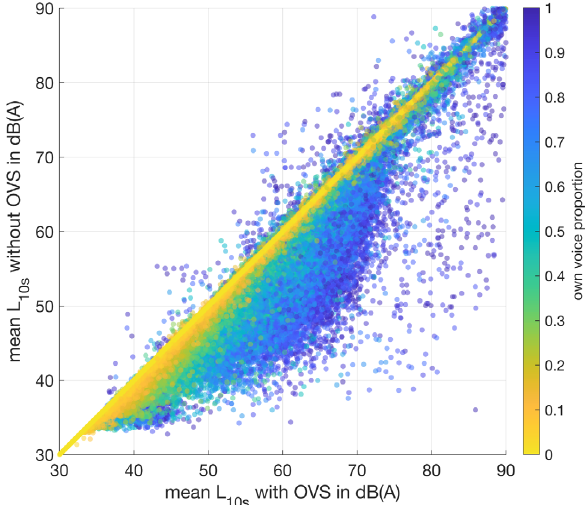
Figure 8. Distribution of the mean A-weighted SPL calculated for 10 s-intervals with 50% overlap for all recording days of one participant, on the horizontal axis including OVS and on the vertical axis excluding OVS. The color indicates the proportion of OVS in each interval. Only this participant showed a cluster of dots with high OVS proportions for rather low